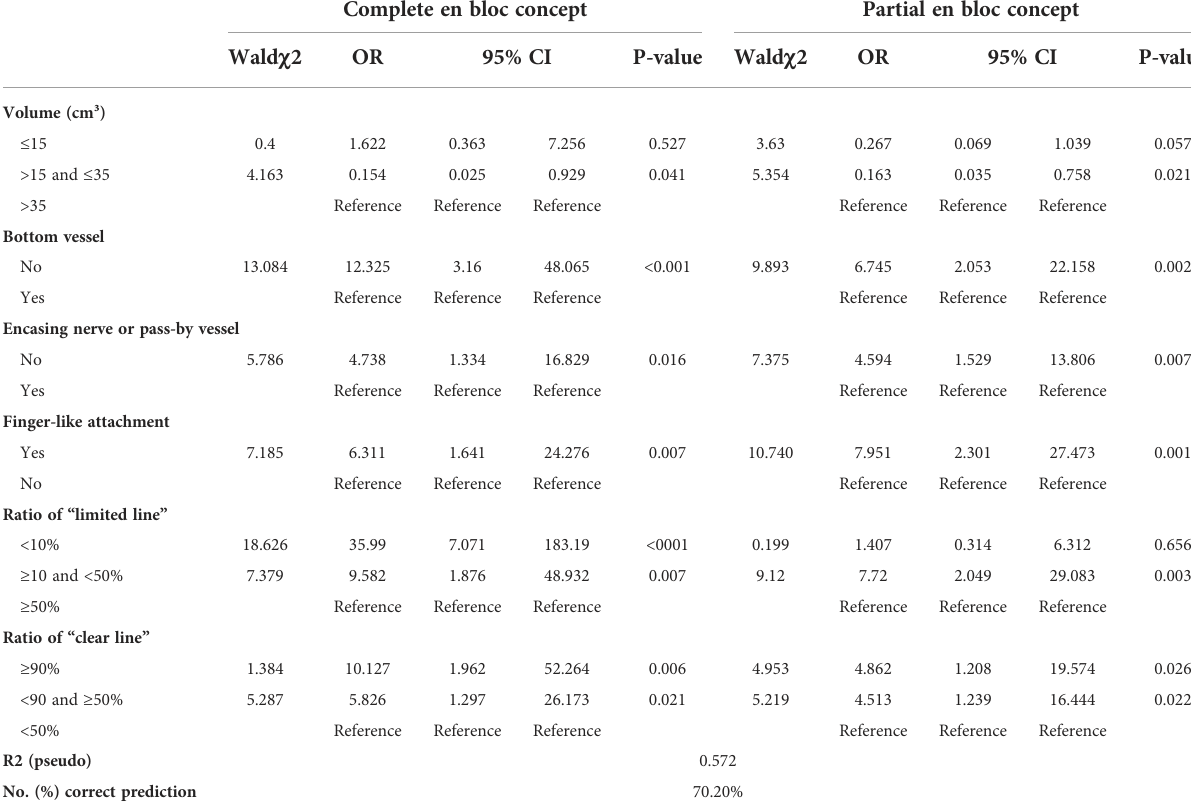
TABLE 3 Multivariate multinomial logistic regression with the piecemeal concept as the base